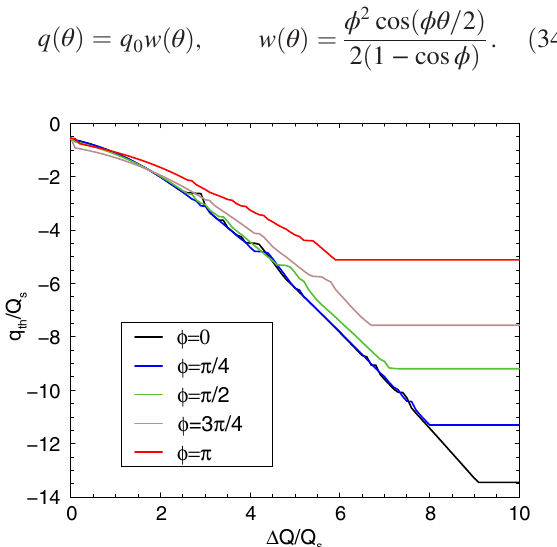
FIG. 10. TMCI threshold of an oscillating wake with phase advance ϕ within the bunch of length Δ θ ¼ 2 . The approximation with n (36 modes) is used; the horizontal lines mark the end max ¼ of the applicability